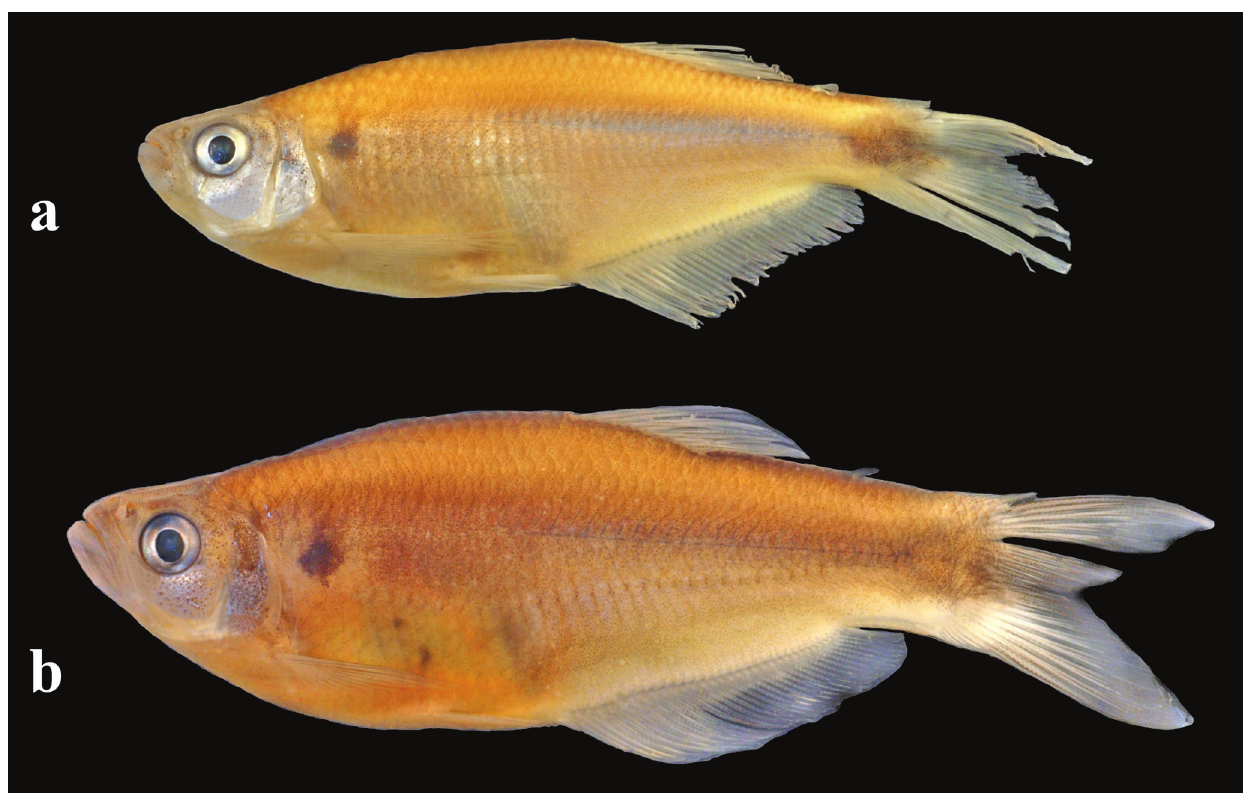
Fig. 9. ( a ) Chrysobrycon hesperus , MUSM 28665, 50.70 mm SL; ( b ) C. myersi , MUSM 38671, 60.66 mm